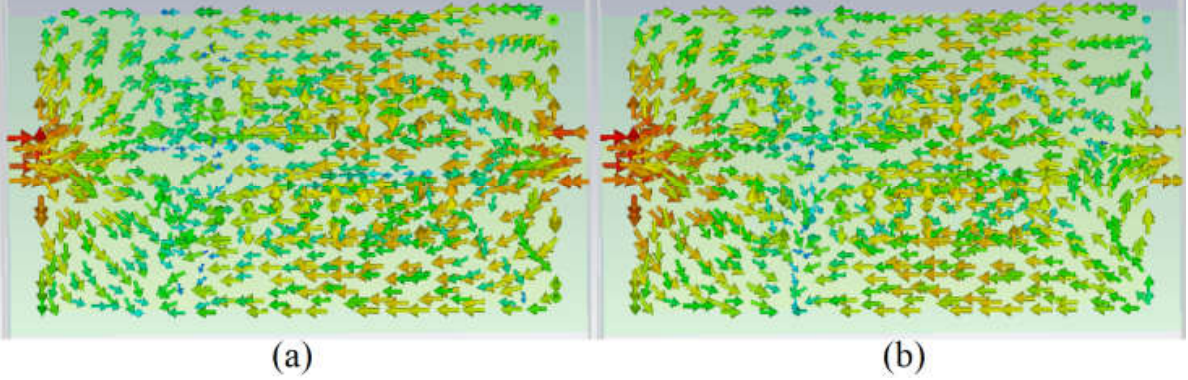
Figure 5. The surface current distribution of the LWA antenna (a: at 3.4 GHz, b: at 5.6 GHz).